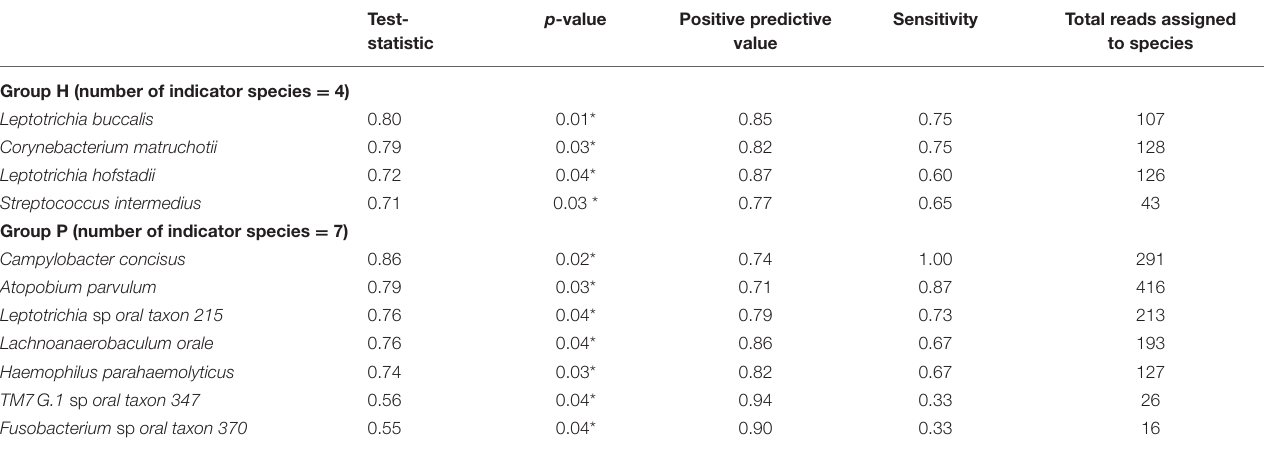
TABLE 4 | Indicator species of P and H groups.